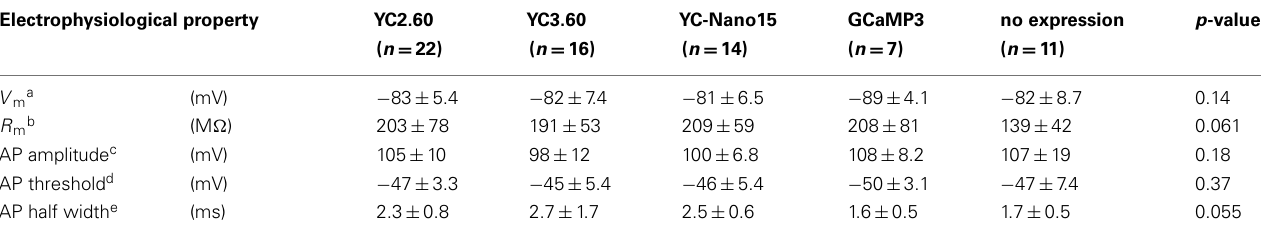
Table 1 | Electrophysiological properties of layer 2/3 pyramidal cells expressing GECIs.